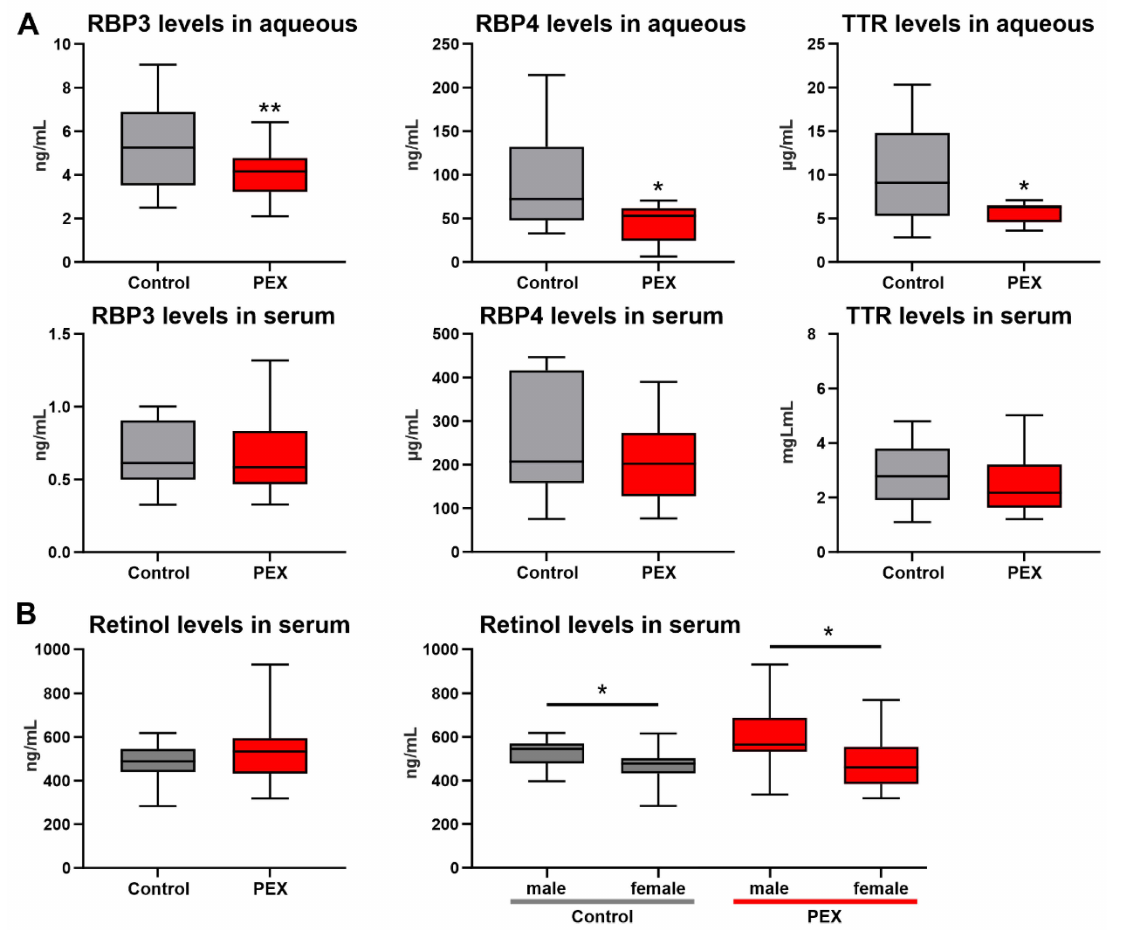
Figure 4. Levels of retinol and retinol carrier proteins in aqueous humor and serum of PEX and control patients. ( A ) ELISA analysis of levels of RBP3 (retinol-binding protein 3), RBP4 (retinol-binding protein 4), and TTR (transthyretin) in aqueous humor (n ≥ 15) and serum samples (n = 12) of PEX and control patients. ( B ) HPLC analysis of serum retinol levels in PEX and control patients (n = 34). Data are presented as box-and-whisker plots displaying the median (line), lower and upper quartiles (boxes), and minimum-maximum (whiskers). Asterisks indicate significant differences between groups (* p < 0.05, ** p < 0.01; unpaired t